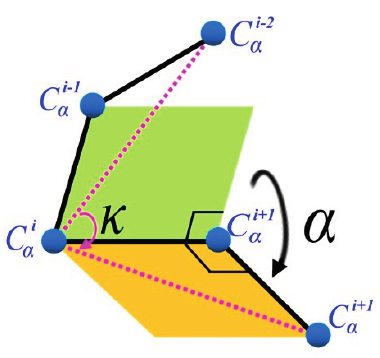
Figure 4. ( κ , α ) pair backbone angle